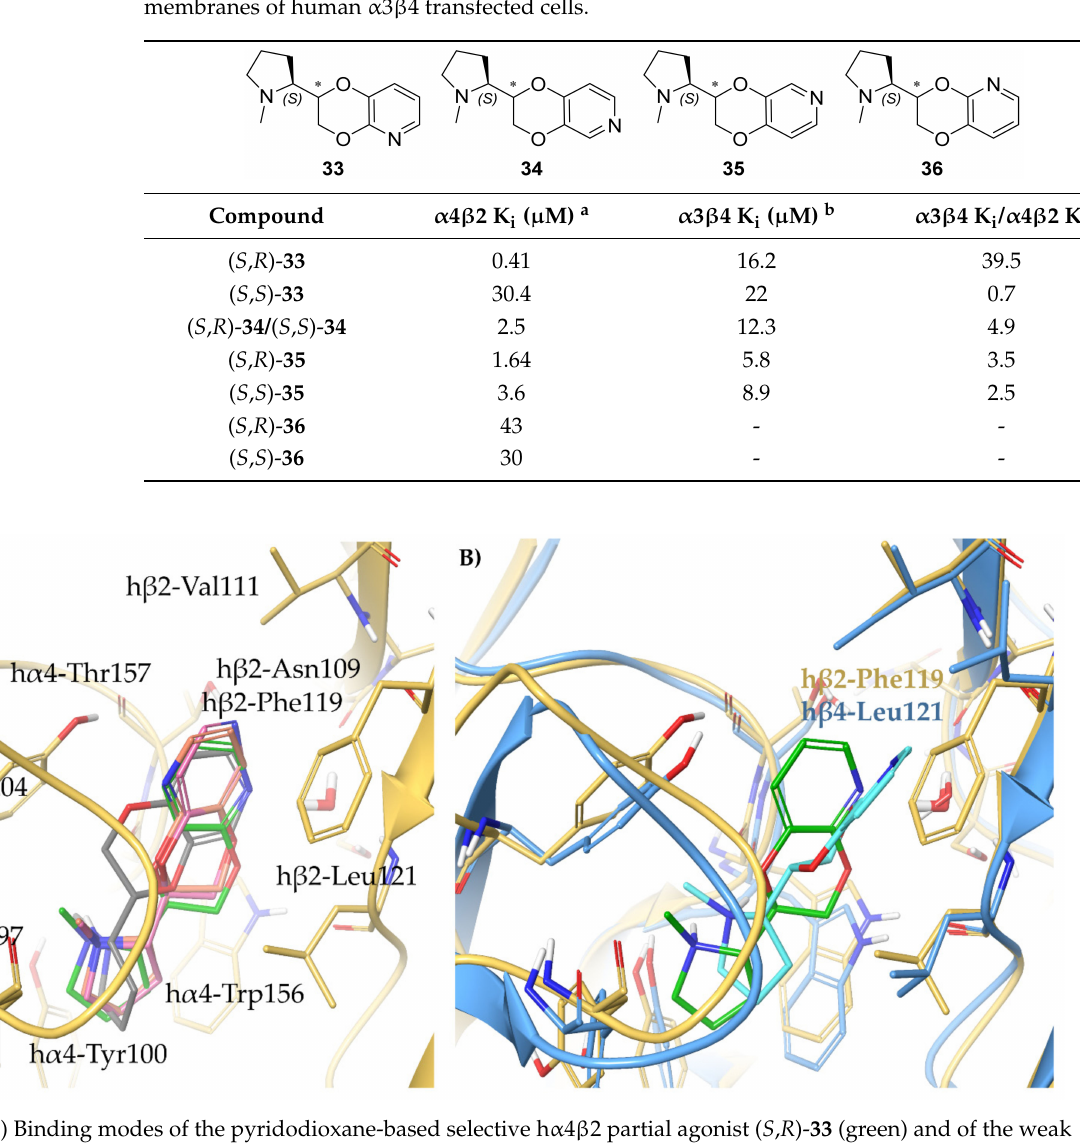
Figure 10. ( A ) Binding modes of the pyridodioxane-based selective h α 4 β 2 partial agonist ( S , R )- 33 (green) and of the weak binders ( S , R )- 34 (pink), ( S , R )- 35 (grey), and ( S , R )- 36 (faded orange) at the h α 4 β 2 binding site (adapted from 6CNJ, yellow residues, and yellow backbone cartoons). ( B ) Superimposition of ( S , R )- 33 bound at the h α 4 β 2 binding site (green ligand, yellow residues, and yellow backbone cartoons, adapted from 6CNJ) and bound at h α 3 β 4 binding site (cyan ligand, light blue residues, and backbone cartoons, adapted from